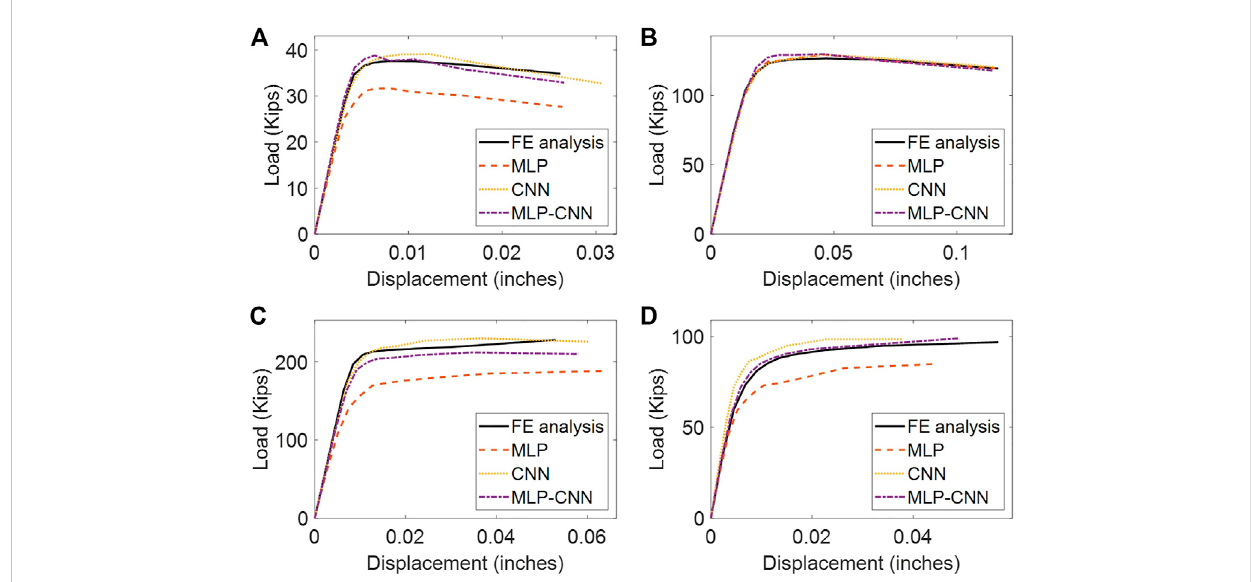
FIGURE 9 Comparison oftheload-displacementcurvespredictedbytheneuralnetworkswiththetargetload-displacementcurvesobtainedfromFEanalysis. (A – D) show load-displacement curves produced for four different test plate FE models with varying expected failure loads of approximately: (A) 35 kips, (B) 125 kips, (C) 215 kips, (D) 85